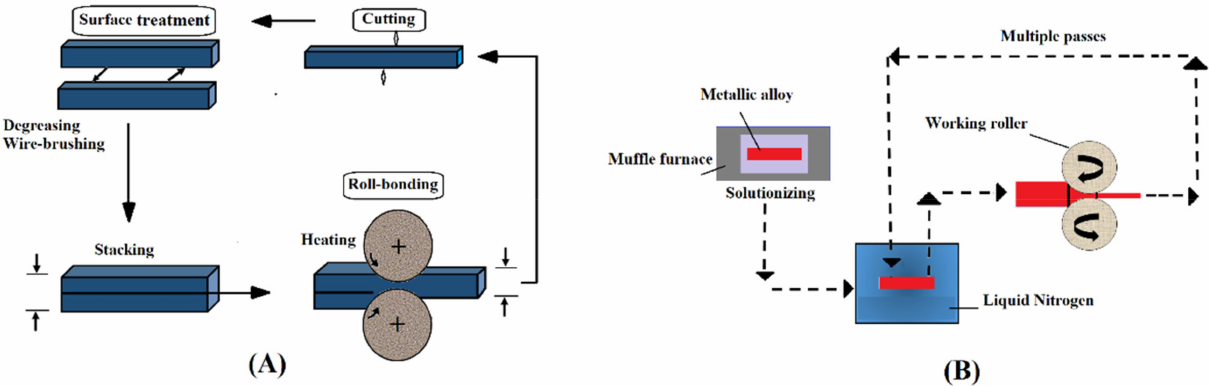
Figure 9. Accumulative roll bonding ( A ); reproduced from [6], with permission from Elsevier, 2020. A schematic of the cryo-rolling process ( B ); reproduced from [73], with permission from Elsevier,